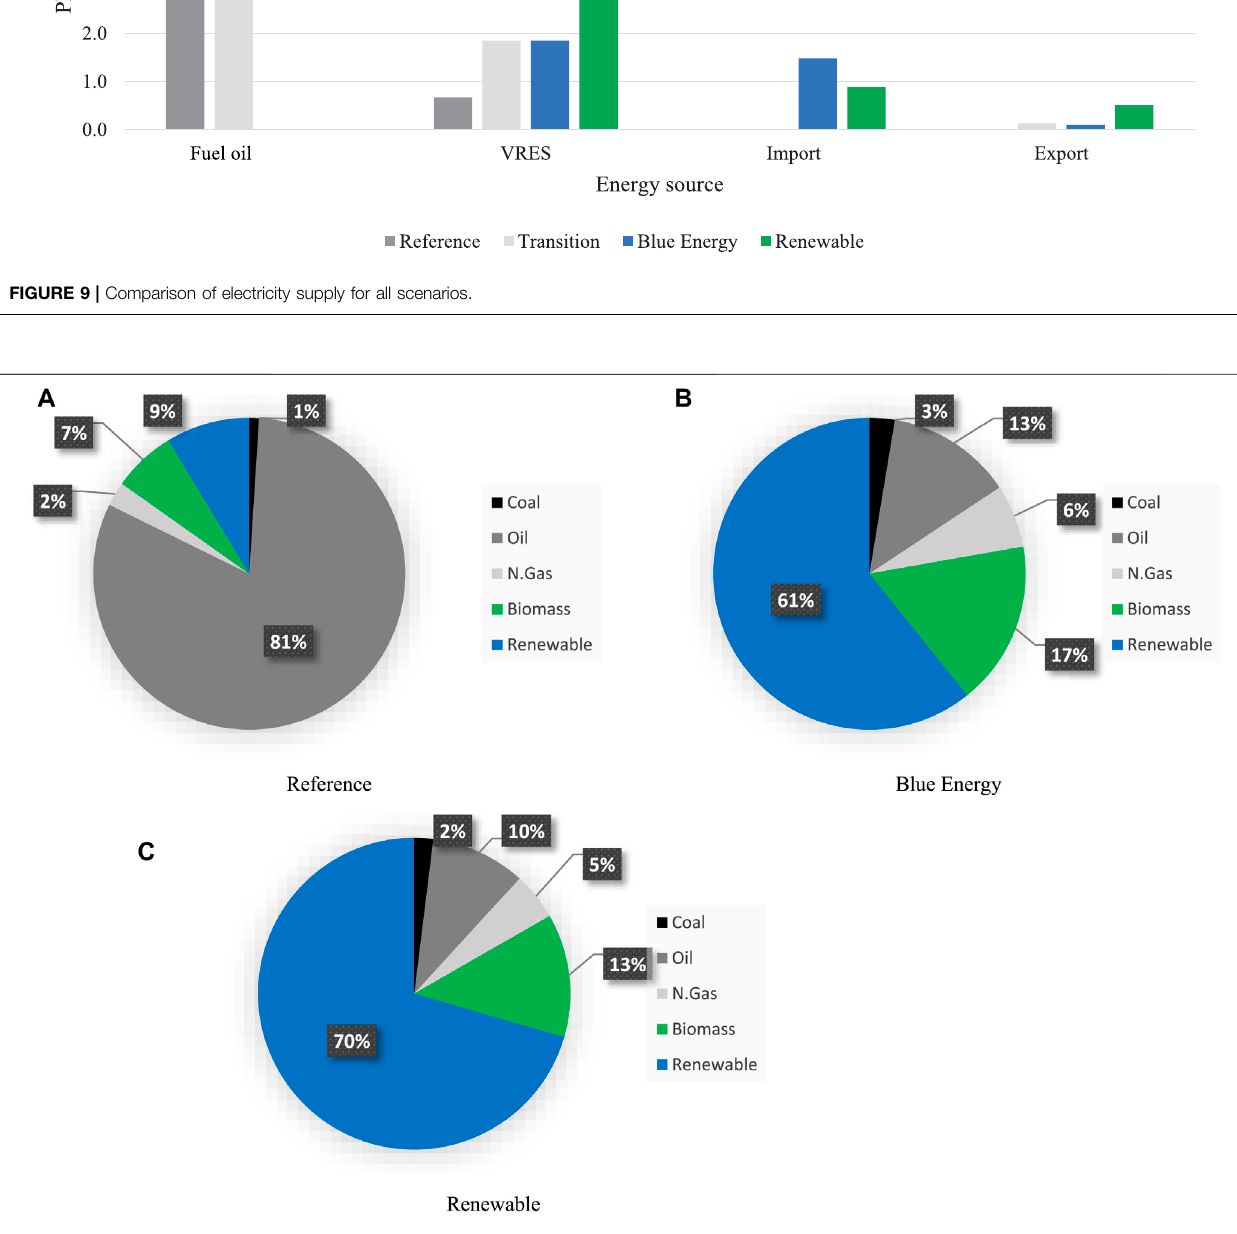
FIGURE 10 | Comparison of fuel consumption for Reference (A) , Blue Energy (B) , and Renewable (C) scenarios.